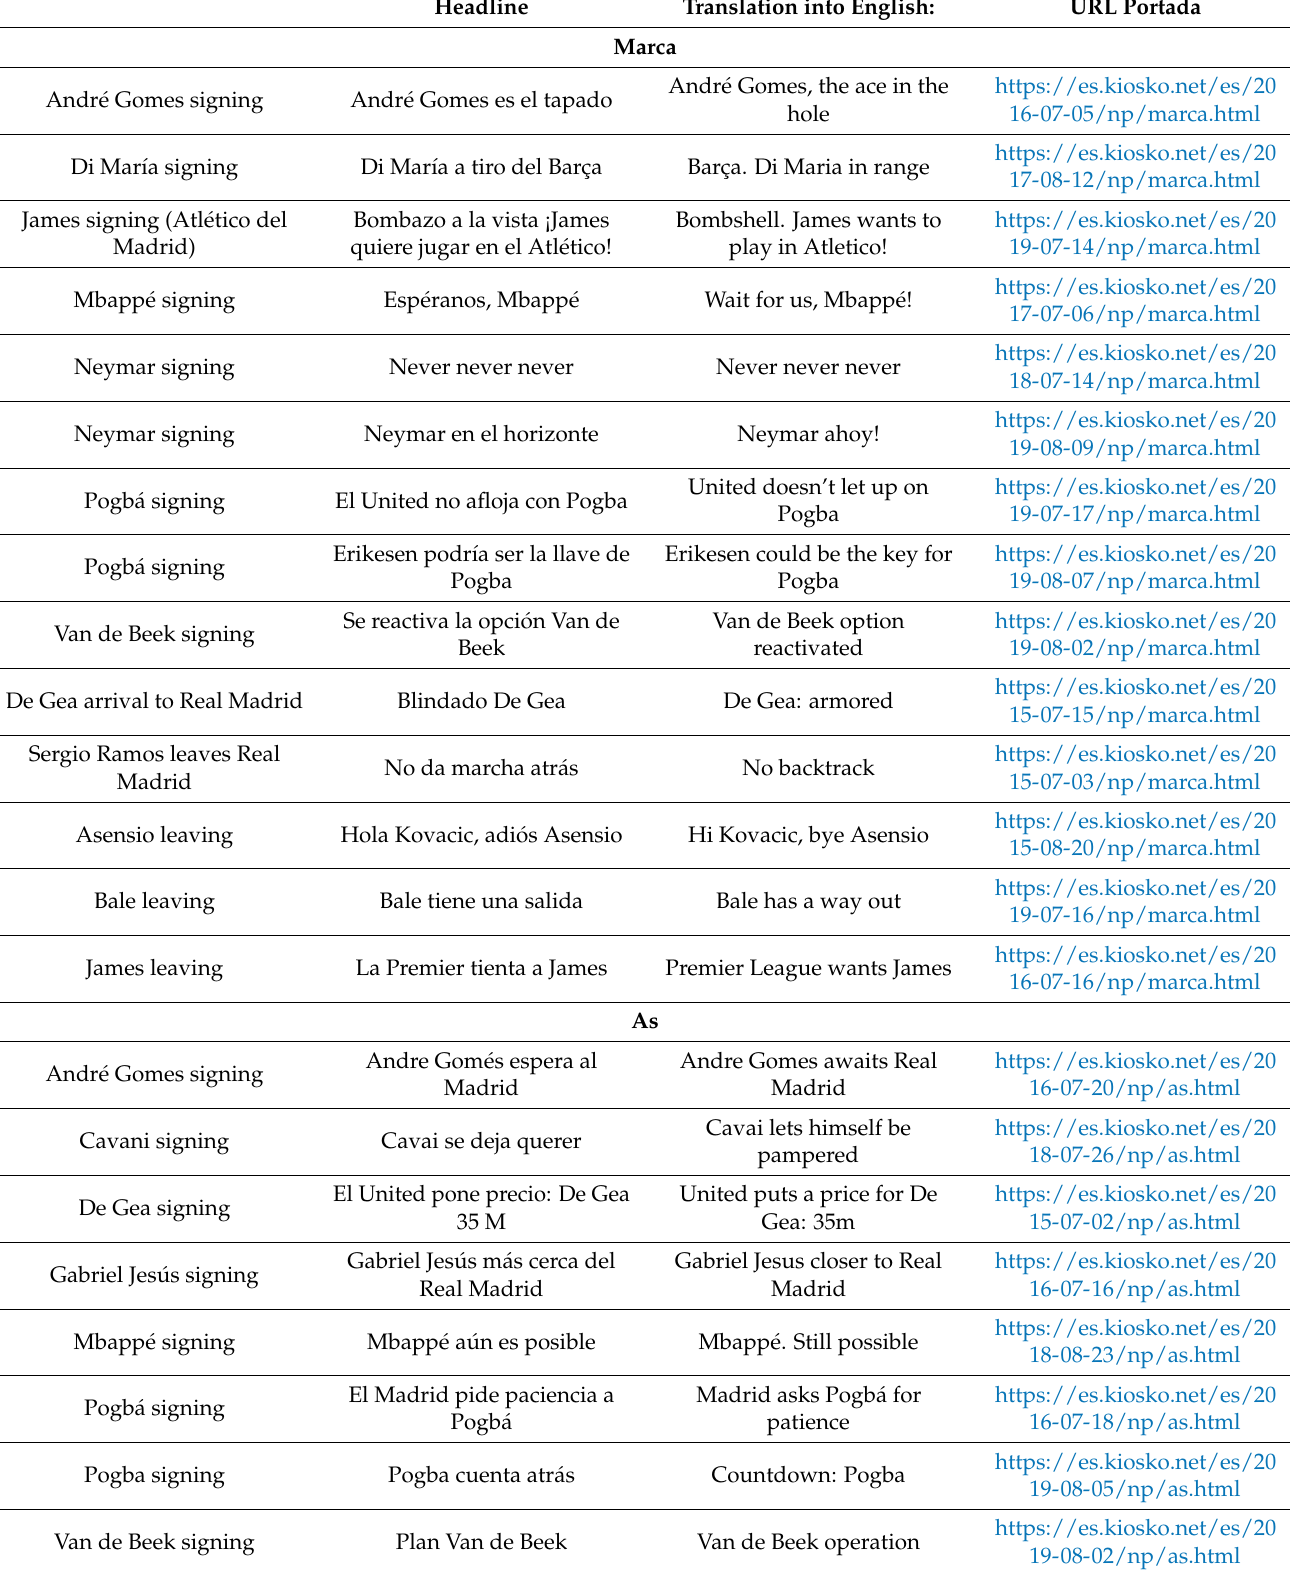
Table 5. Headline examples. Compiled by